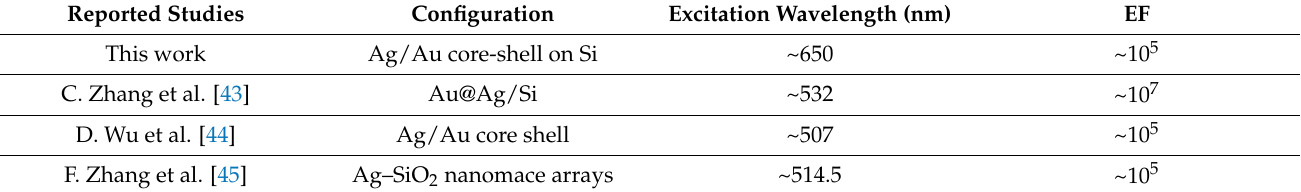
Table 1. Comparison between the enhancement factor of this work and other reported work.